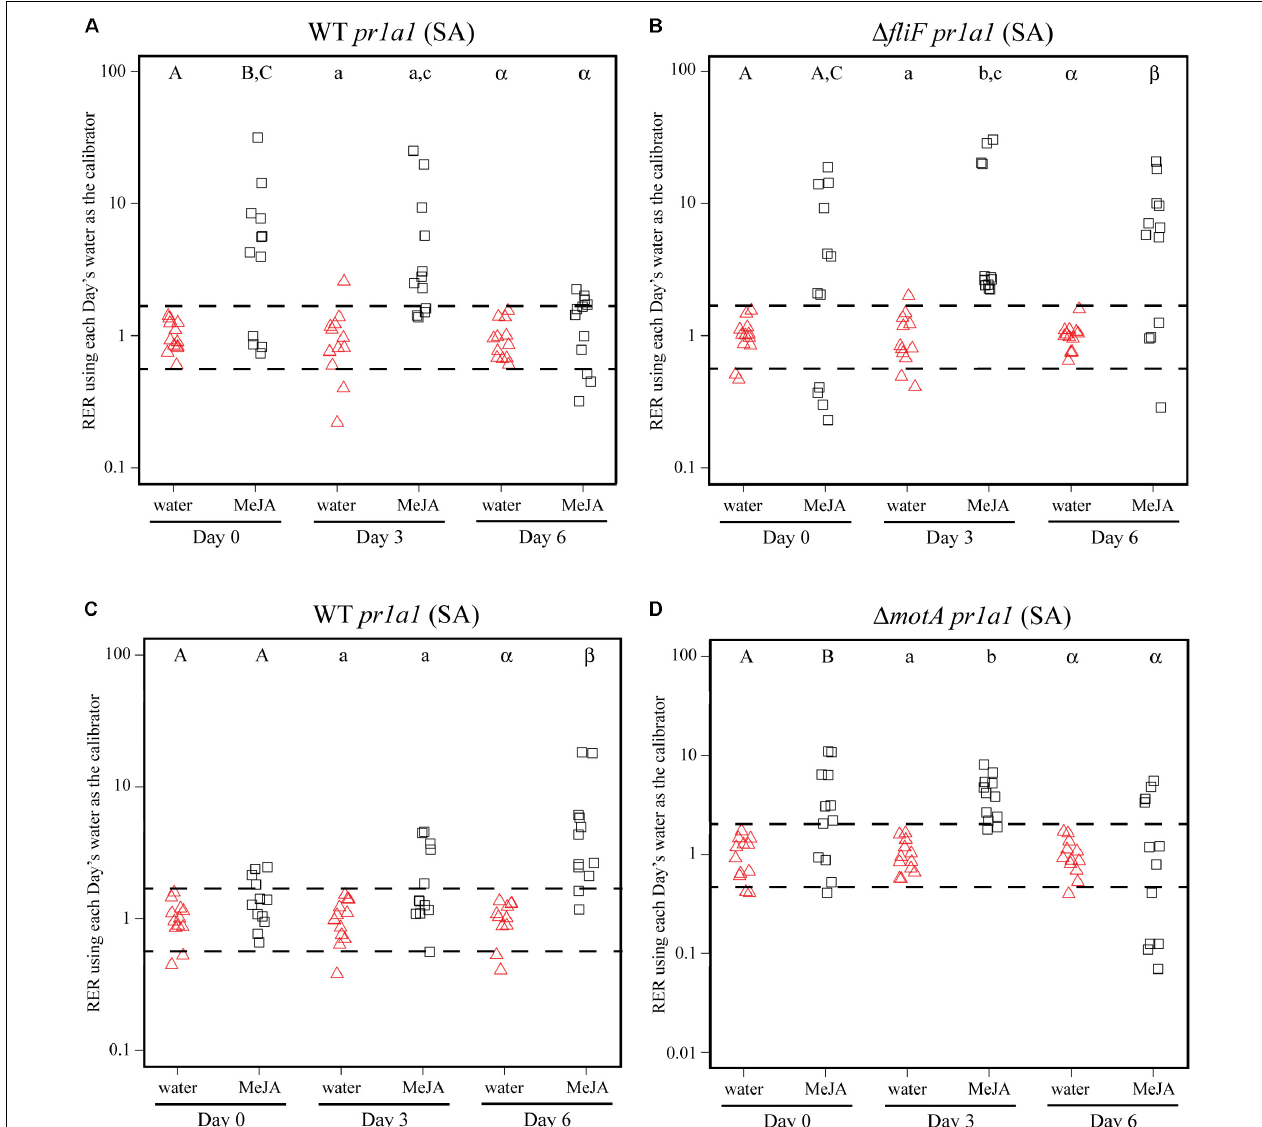
FIGURE 6 | MeJA treatment and S. Typhimurium inoculation lead to activation of the SA response. Plant pr1a1 gene expression was quantified at days 0, 3, and 6 post-inoculation with wildtype S. Typhimurium (WT; A,C ), the fliF ::Kan mutant (B) or the motA ::Kan mutant (D) for plants sprayed with water (red triangles) or MeJA (black squares) and displayed as relative expression ratios (RER) using transcription on plants treated with water as the calibrator. The fliF ::Kan and motA ::Kan mutants were tested in separate experiments, and the corresponding wildtype data are displayed for each experiment. The dashed line indicates a twofold change in transcription, and each symbol represents data collected from one tomato plant. Transcript levels were quantified from three biological replicates with samples taken from four plants per treatment per time point. Letters denote significant differences between treatments within a single time point in each experiment ( P <